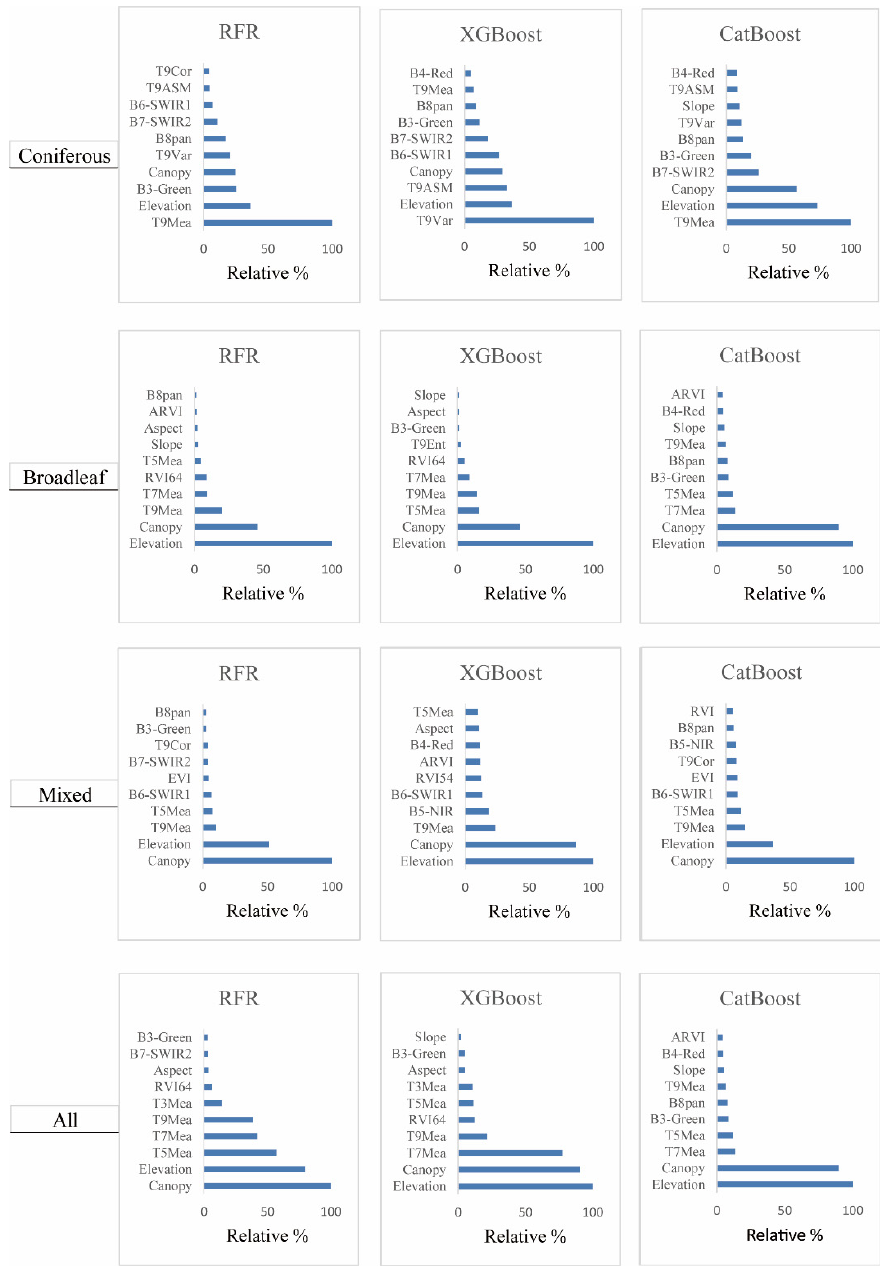
Figure A2. Variable importance ranking for the different forest types by combining feature selection method (VSURF) and three machine learning algorithms (RFR, XGBoost, and CatBoost).